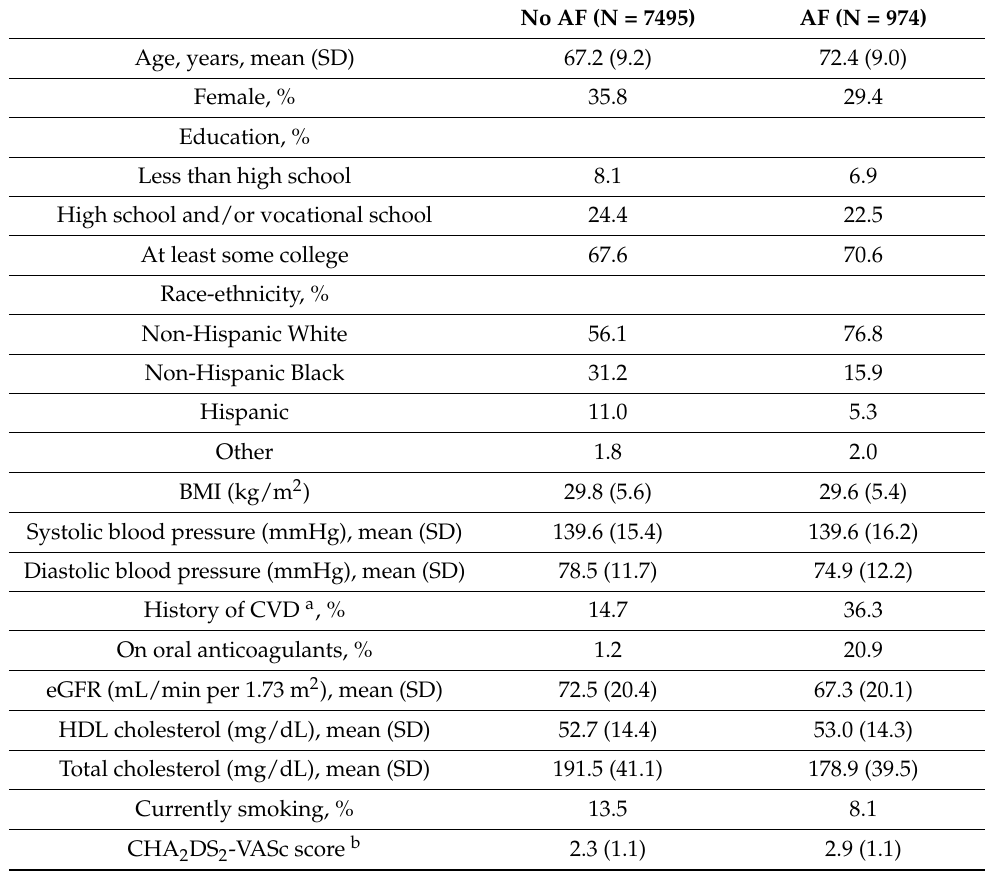
Table 1. Participant characteristics by AF status,